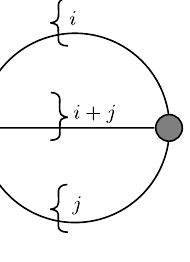
Figure 5. Left panel: The Φ functional for the general case of A particle correlations in a many-fermion − system, whereby all bipartitions A = i + j into lower order clusters of sizes i and j shall be considered; Right panel: Equivalent representation of the diagram in the left panel with the highest order cluster Green’s function and the vertex functions replaced by the cluster T matrix, see Figure